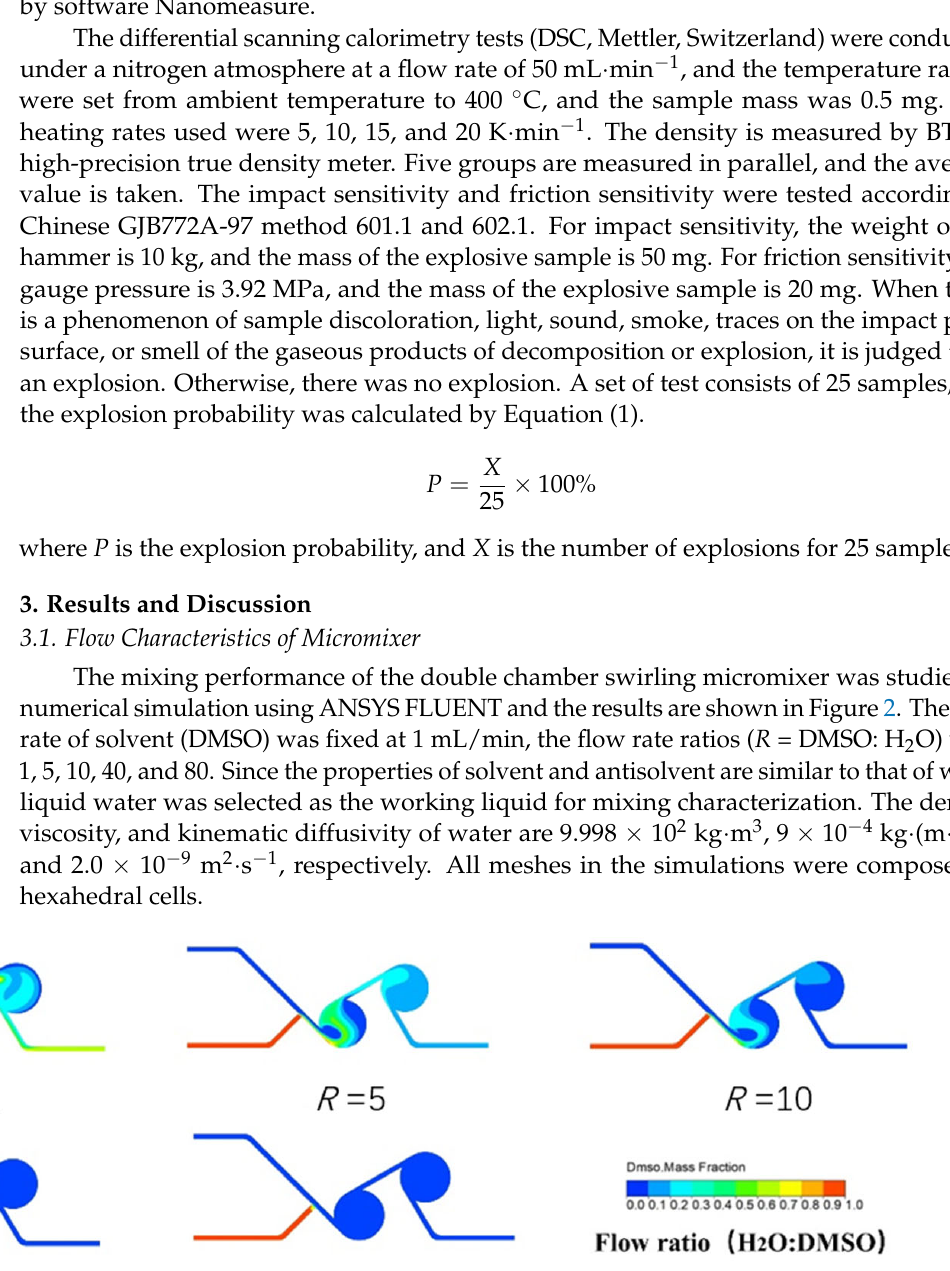
Figure 3. Influence of flow ratio on mixing index and residence time. It can be clearly seen from Figures 2 and 3 that the double chamber micromixer has a faster mixing speed and higher mixing efficiency. With the increase in flow ratio, the mixing coefficient increases almost linearly and finally tends to be stable. When the flow ratio was 10, the mixed coefficient reached 0.998 and then stabilized with a fluctuation range of 0.3%. When the ratio is greater than 10, the fluid residence time is less than 0.2 s. In practical applications, we need to consider the mixing efficiency and solvent amount, so the flow ratio between 5 and 10 will be the primary choice. 3.2. Particle Size Control of Ultrafine HMX The crystal morphology and PSD of recrystallized HMX with different flow ratio R have been showed in Figure 4. Compared with the raw material, the recrystallized HMX